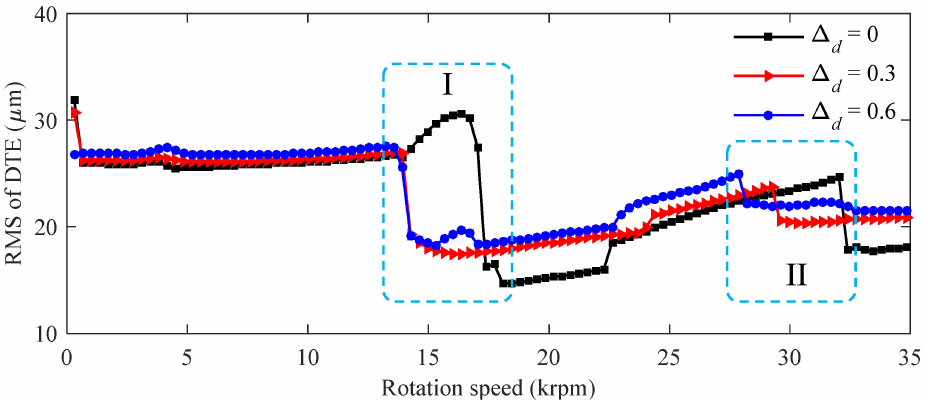
Figure 9. RMS of the DTE of the gear pair in acceleration